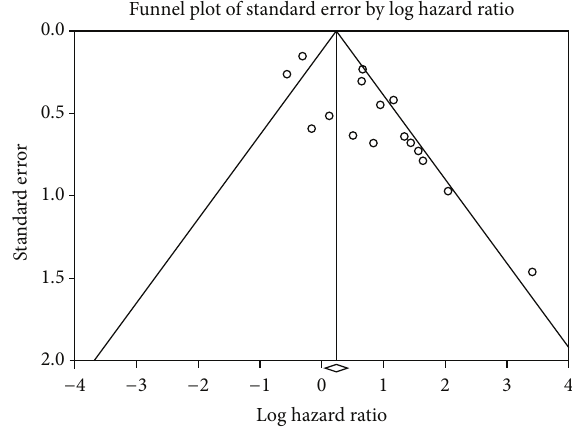
Figure 8: Publication bias pooled association between VEGF expression and overall survival.